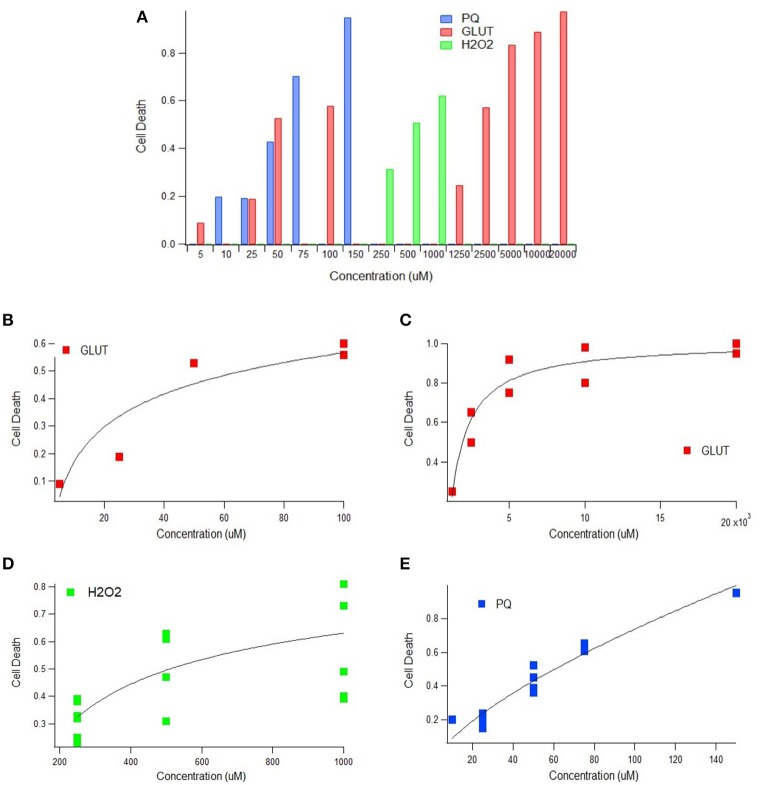
Cell death as a function of oxidant concentration In vitro. (A)
In vitro cell death following exposure to paraquat, glutamate, or hydrogen peroxide concentrations (uM) (p < 0.05). (B)
In vitro cell death trend plateaus following exposure to physiologically relevant glutamate concentrations (p < 0.05). (C)
In vitro cell death trend following exposure of glutamate in excess of physiologically relevant concentrations (p < 0.05). (D) A scatter plot of concentration vs. cell death of 250, 500, and 1,000 uM of hydrogen peroxide (H2O2) (p < 0.05). Incubation times 2, 4, 6, and 10 h represented from bottom to top (p < 0.05). (E)
In vitro cell death trend following exposure to paraquat, an extrinsic oxidative stress inducer (p < 0.05).